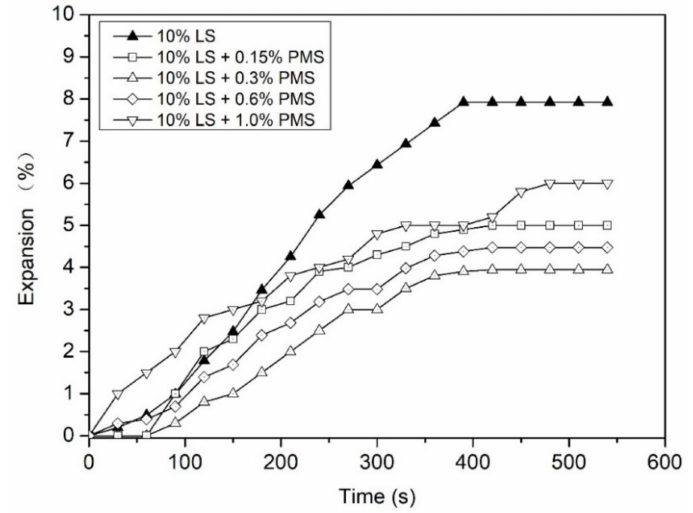
Figure 6. Expansion (before setting) of MAPC mortar samples with 10% limestone fines (LS) with or without defoaming treatment by polyether modified silicone (PMS) defoamer at different dosage of 0.15%, 0.3%, 0.6%, and 1% (by weight of